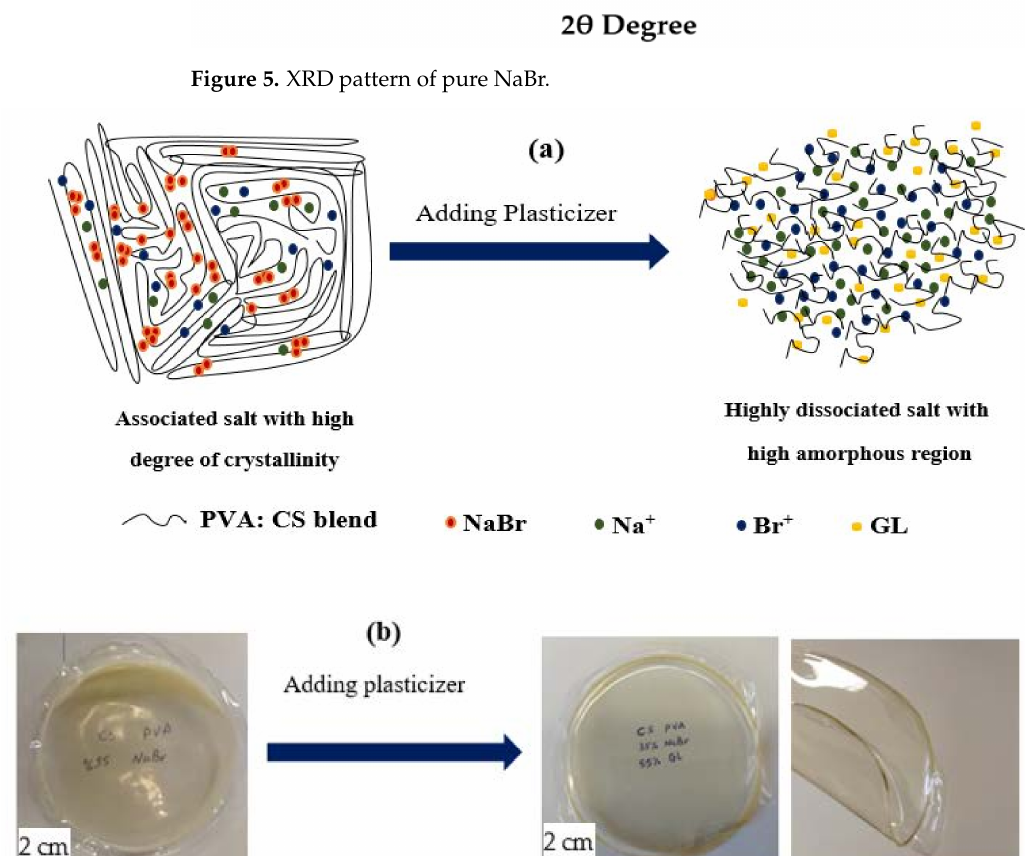
Figure 6. Role of plasticizer on ( a ) the ion dissociation and increase of flexibility and amorphous phase, and ( b ) the film with high content of plasticizer can easily be bending without deformation or tear. The last photograph shows the ability of the film to